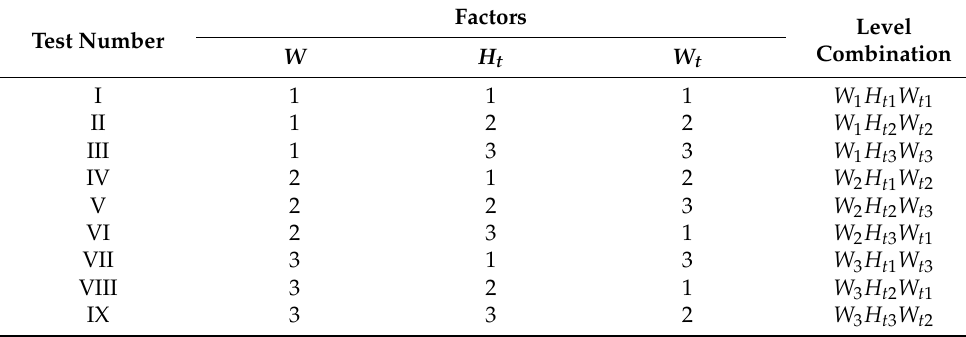
Figure 2. Finite element analysis and corresponding results of plane models for three different parting structures (plane, right-angle tenon-and-mortise (RTM), and dovetail tenon-and-mortise (DTM)): ( a ) diagram of three parting structures; ( b ) finite element analysis of plane models for three parting structures under the same displacement (0.6 mm); ( c ) interfacial separation force; and ( d ) avulsion energy of three parting structures generated during interface separation. Table 1. Orthogonal experiment method